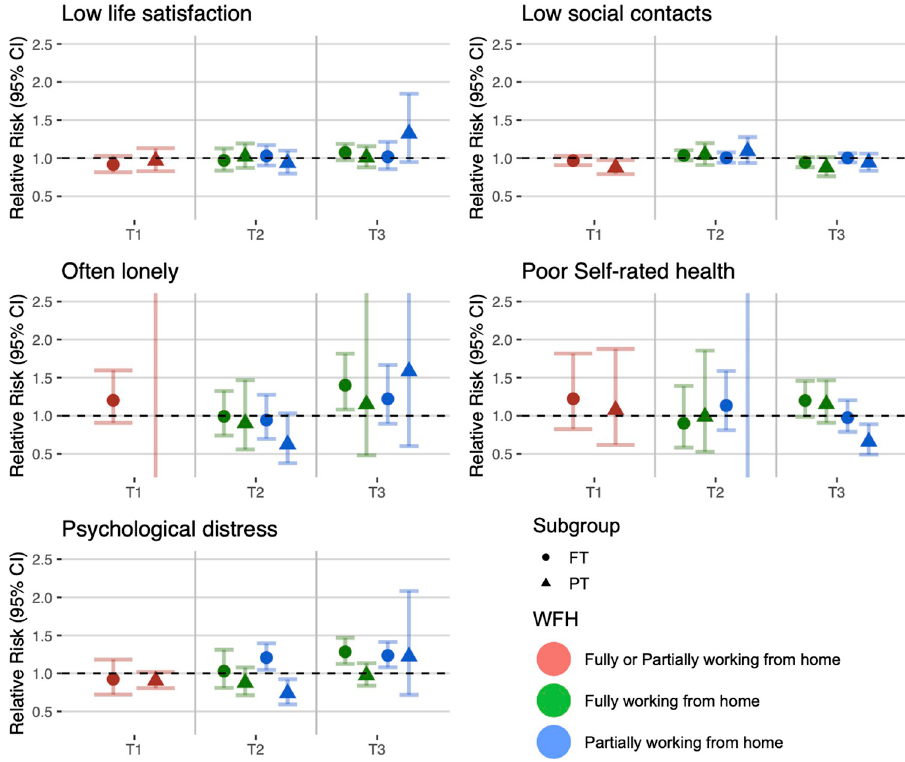
Fig 4. Stratification by full-time and part-time